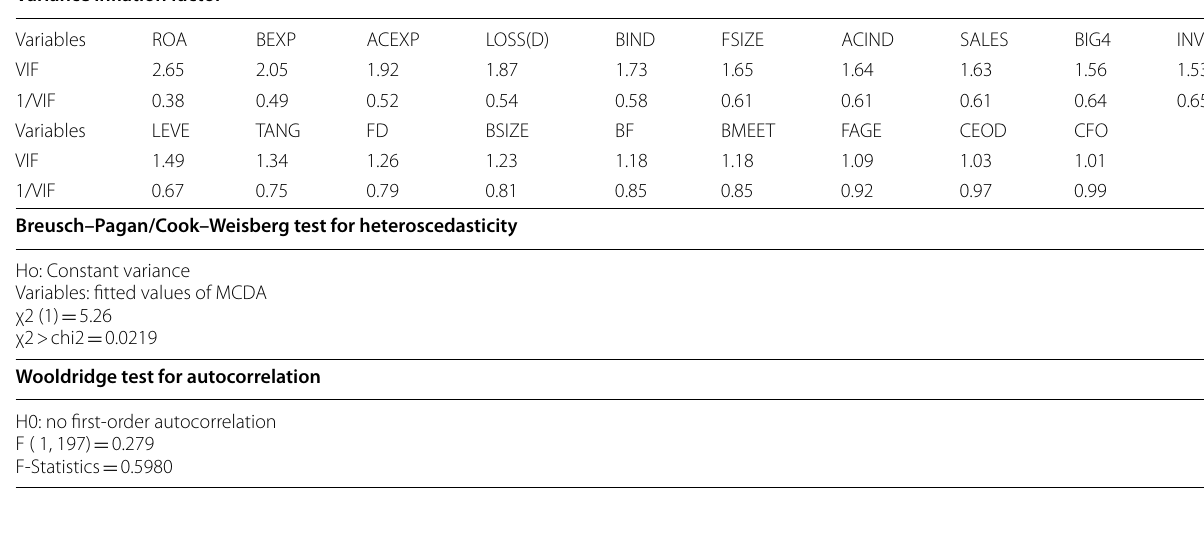
Table 3 The diagnostic tests before regression Variance inflation factor